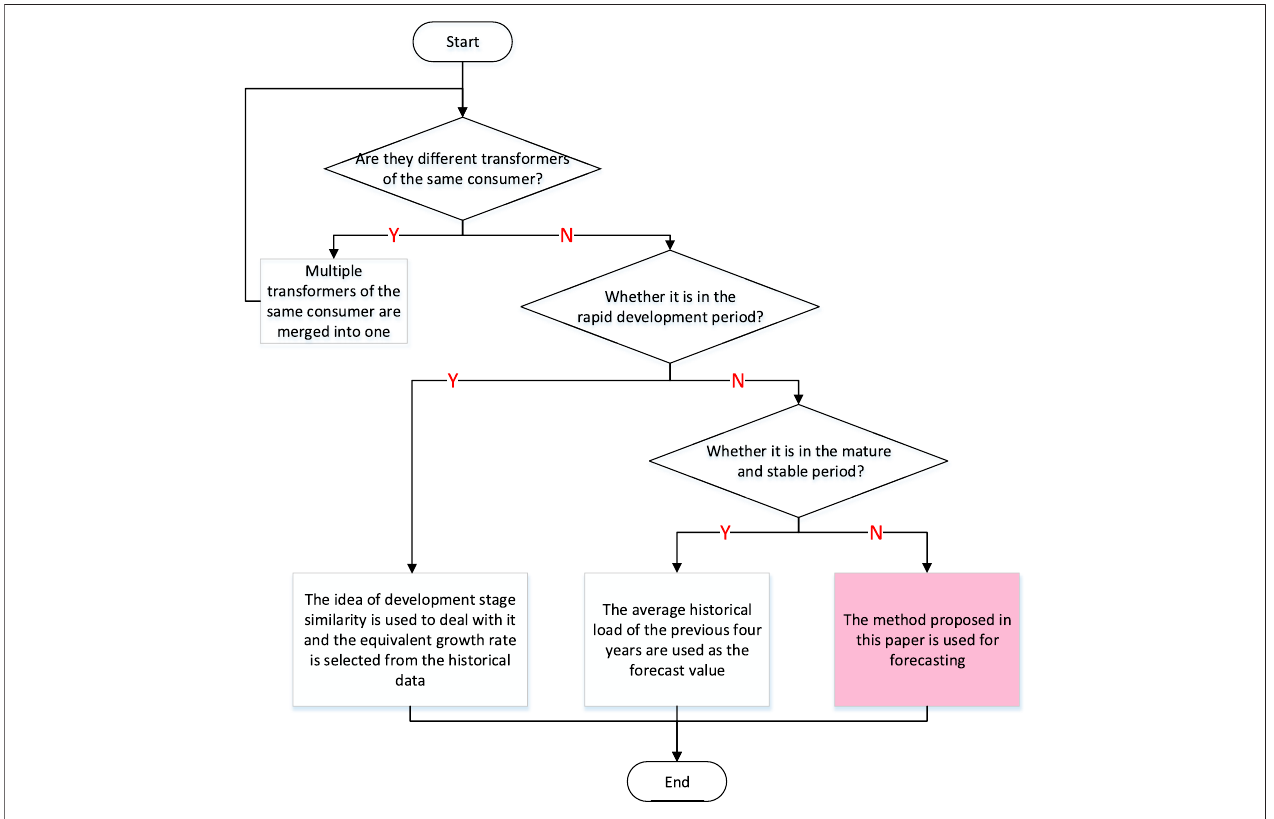
FIGURE 1 | Distribution transformer classi fi cation fl ow chart.